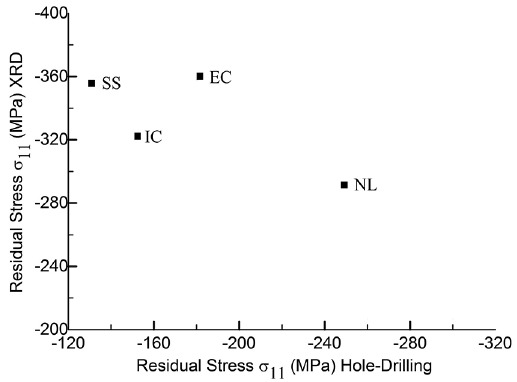
measured by XRD and 11